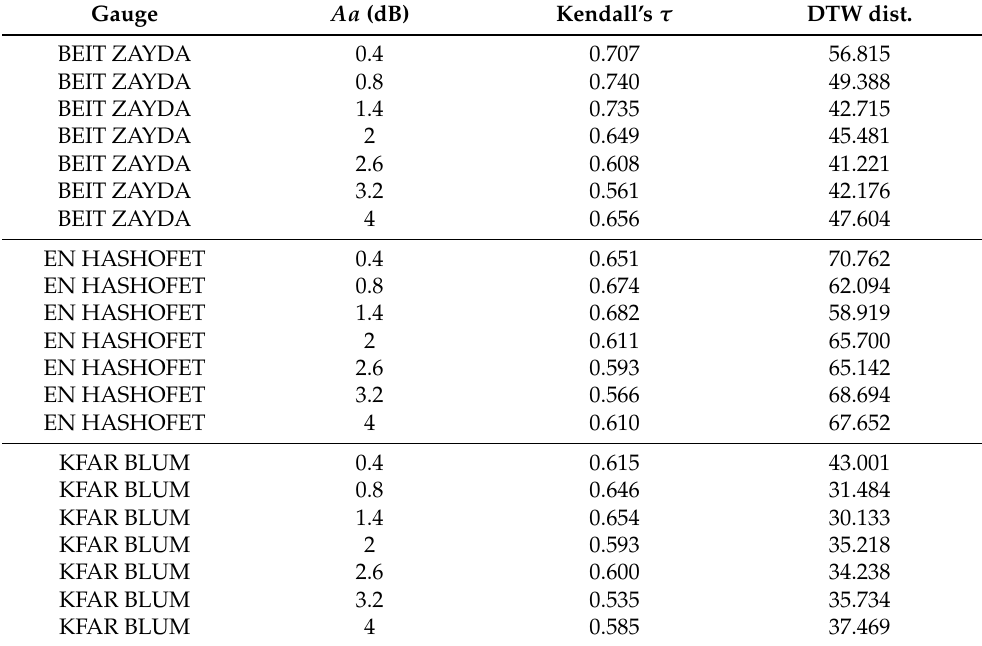
Table 2. Correlation (Kendall’s τ ) and DTW distance between gauge observations and CML-derived rain rates at hourly aggregations for three links. The evaluation is repeated for seven different wet antenna attenuation parameters Aa . These three stations are close to link lines, and this table compares gauge observed rain rates to CML-derived from the nearby link. Both Kendall’s τ and DTW distance are averaged over four storm periods, to determine the optimal wet antenna